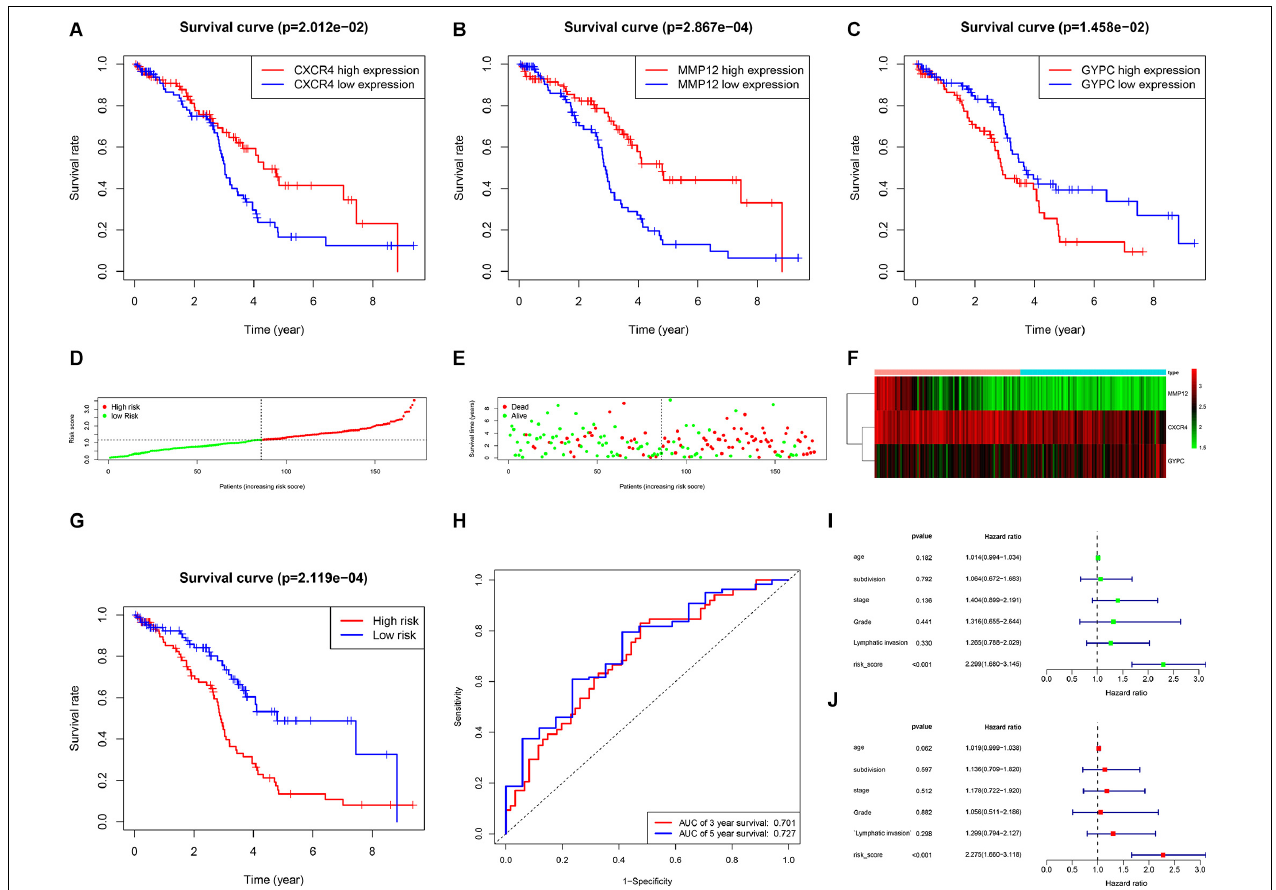
FIGURE 4 | Establishment and evaluation prognostic model. (A–C) Survival rates were calculated between high and low gene expression groups. The red line represents the high gene expression group, and the blue line represents the low gene expression group. (A) CXCR4, (B) MMP12, (C) GYPC. (D–F) Distribution of risk score ranking, survival status, and three DEGs’ expression heat map. (G) Survival curves of patients in the high-risk group and low-risk group. (H) 3- and 5-year ROC curves. ROC, receiver operating characteristic; AUC, area under the curve. (I,J) Univariate and multiple regression analysis was performed to assess the relationship between age, grade, stage, lymphatic invasion, subdivision, and risk scores.